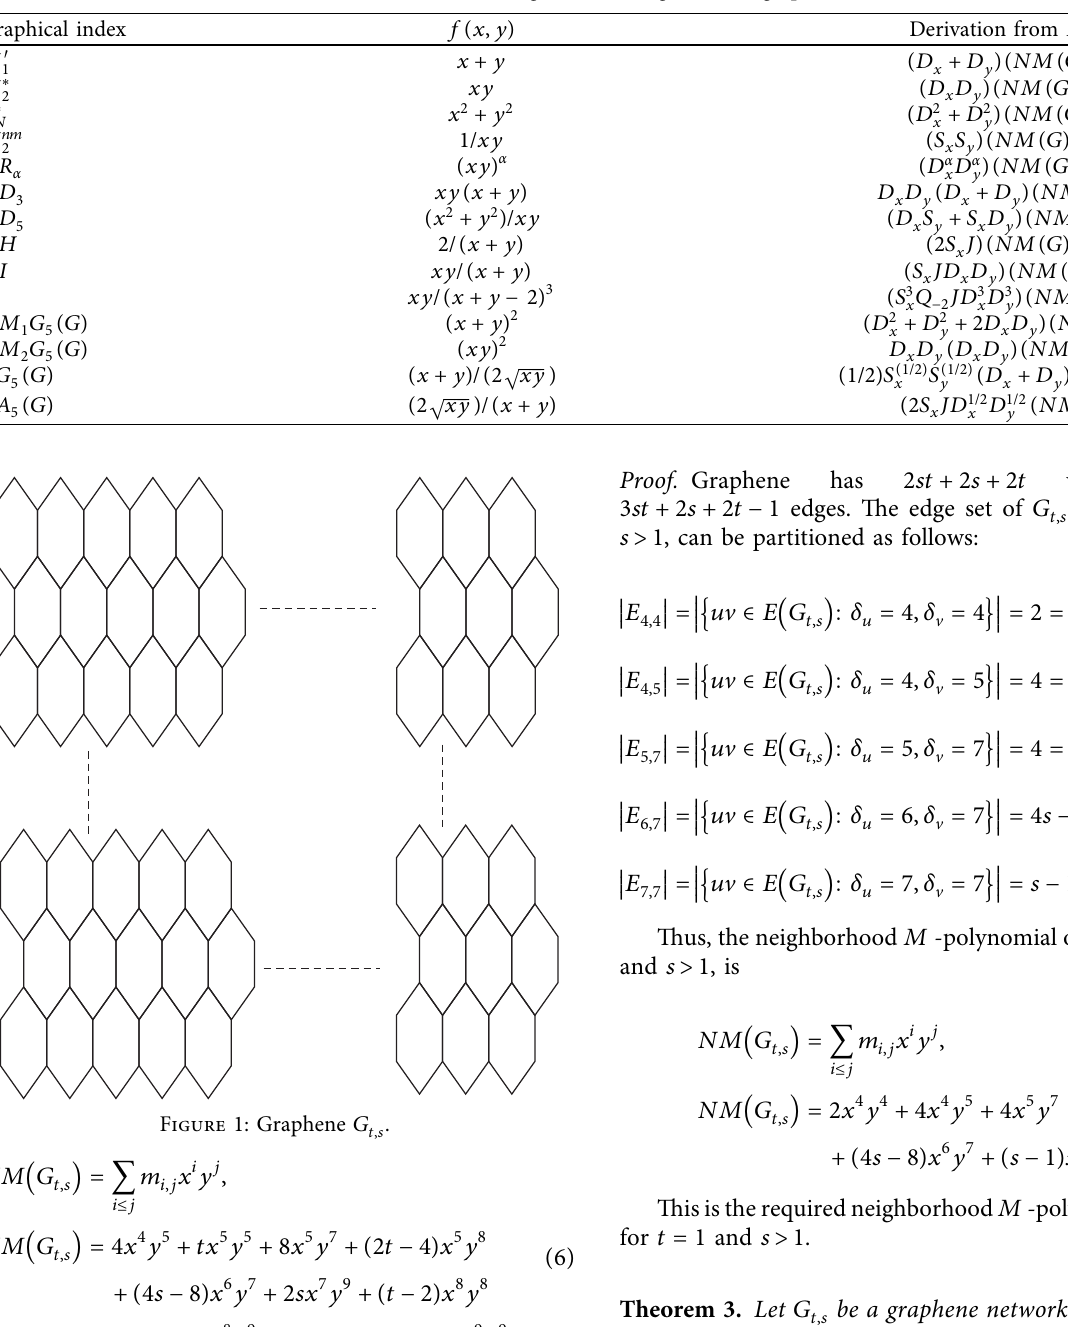
Table 1: Derivation of some neighborhood degree-based graphical indices [18].